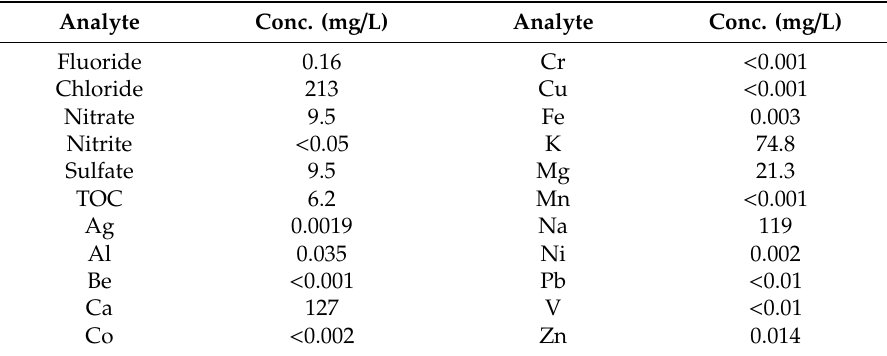
Table 1. Chemical analysis of ultrafiltered